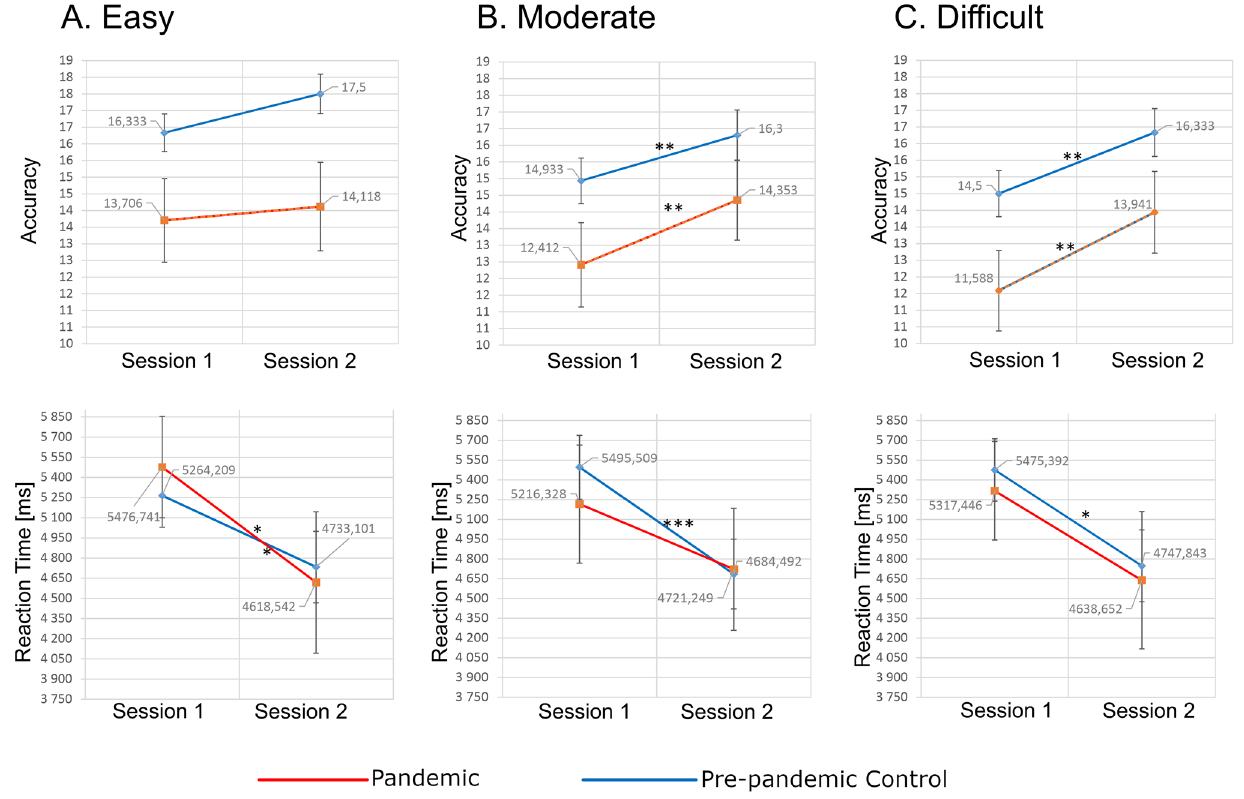
Figure 4. Accuracy and reaction times in a transitive reasoning task. Mean accuracies (upper row) and mean reaction times (lower row) results for Pandemic and Pre-pandemic Control groups in the easy ( A ), moderate ( B ) and difficult ( C ) task variants. The stars above lines joining results of Sessions-1 and Session-2 denote significant differences (* p < 0.05; ** p < 0.01; *** p < 0.001) of Chi 2 post-hoc test followed by Friedman’s test.). Created using JASP 0.14.1 (https:// jasp- stats. org).